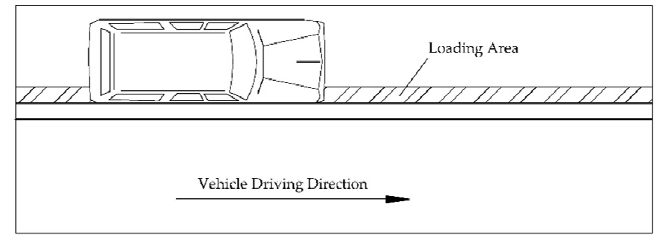
Figure 6. Schematic diagram of the vehicle’s driving trajectory.